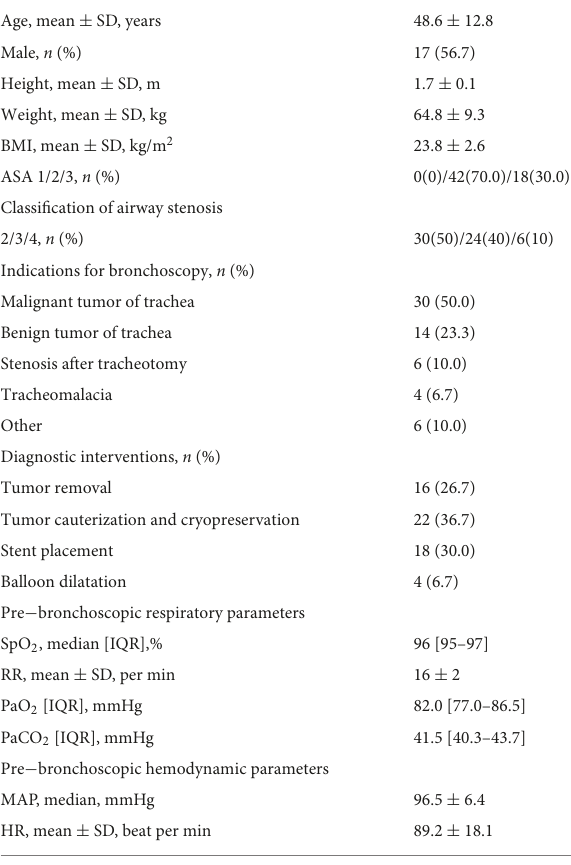
TABLE 1 Characteristics of patients in this study ( n =